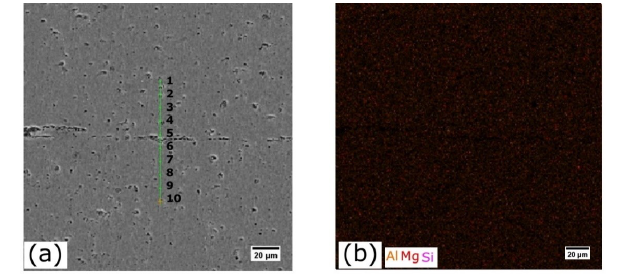
Figure 5: Microstructure in the interface of W7 P-FSSW joint (a) SEM image and (b) EDX map